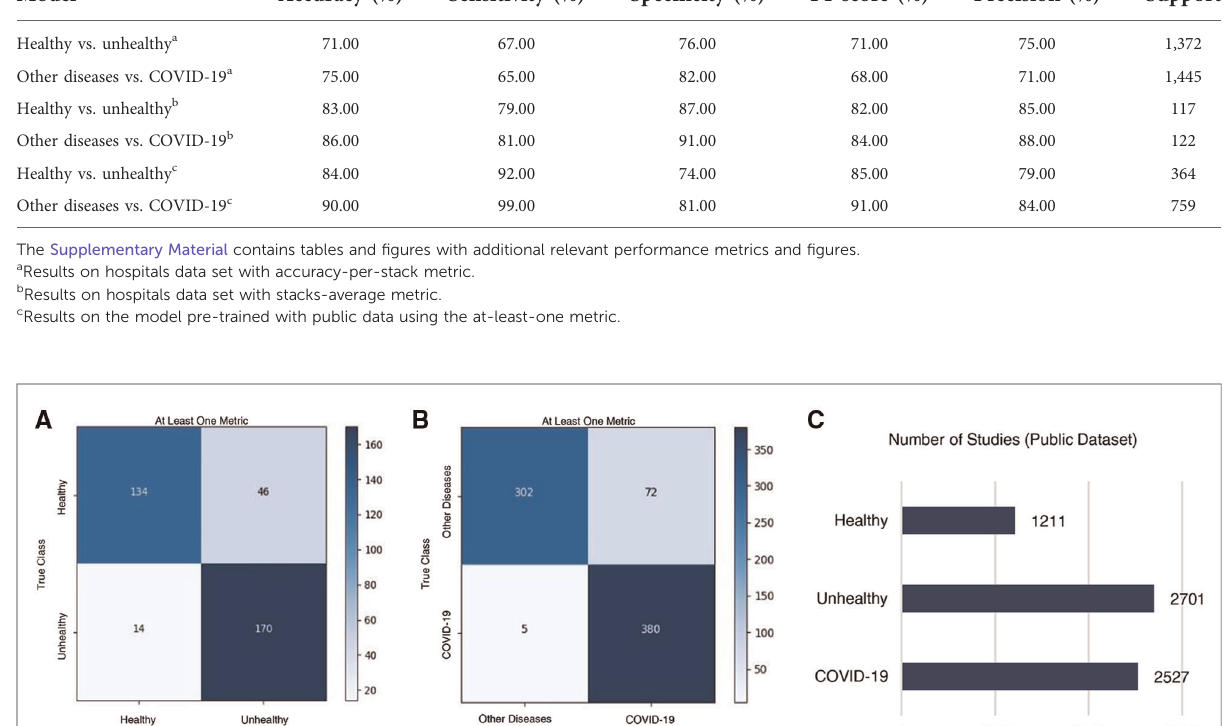
TABLE 2 Performance comparison, on test data, of weakly-labeled lung CT classi fi cation tasks, using the proposed architecture (ChexNet3D). Model